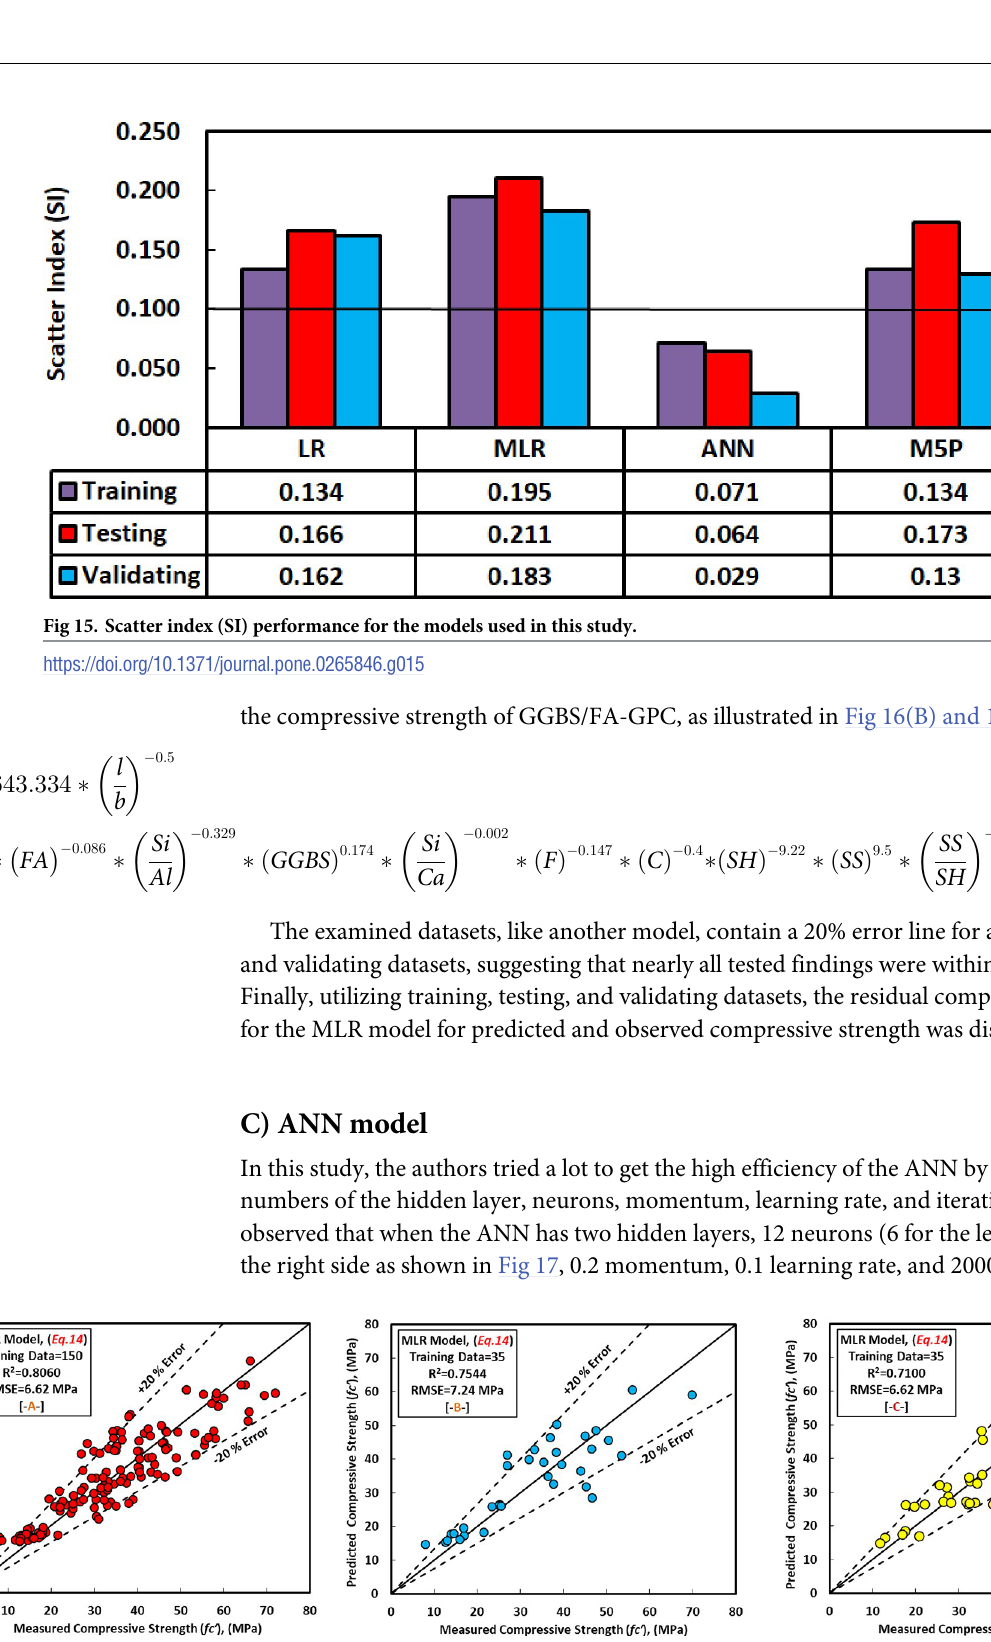
Fig 16. Comparison between measured and predicted compressive strength using MLR model, (a) training data, (b) testing data, and (c) validating data.